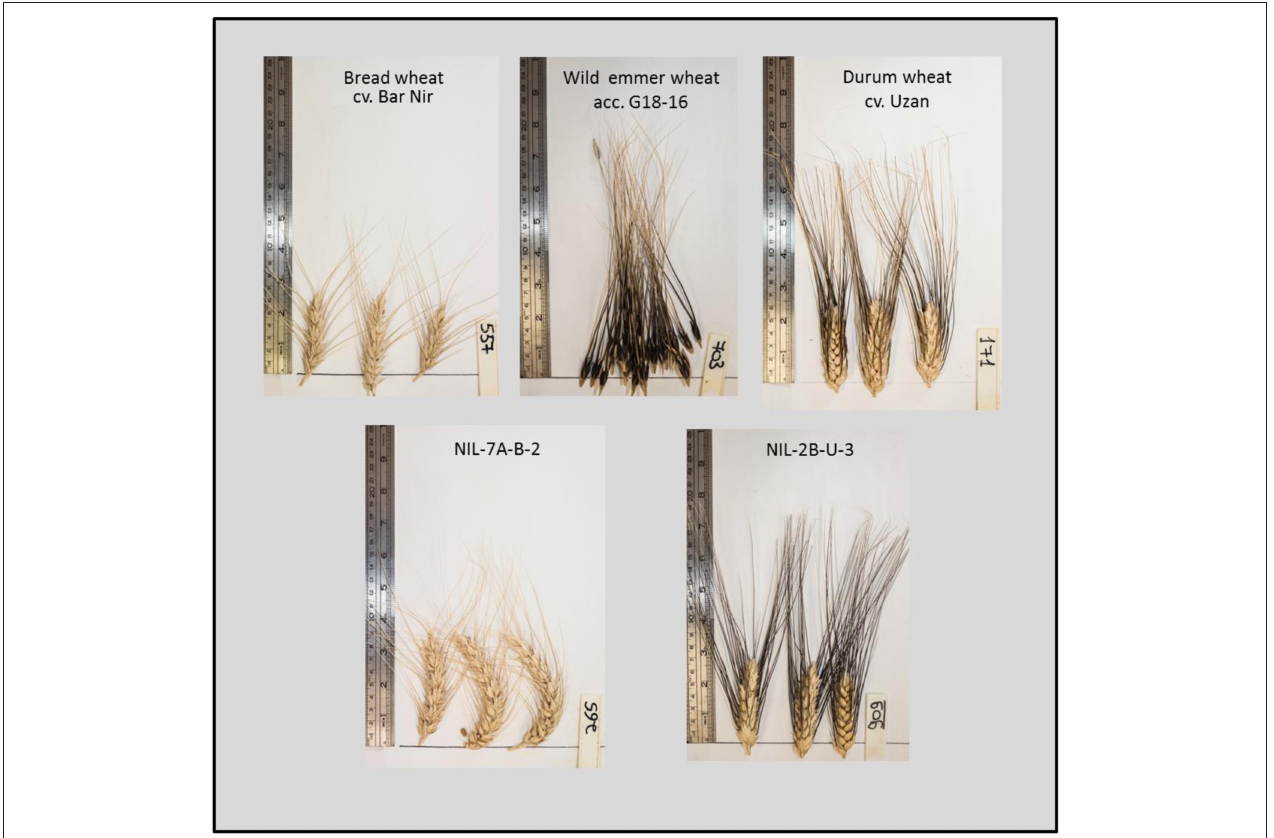
FIGURE 3 | Three first spikes of the wild emmer wheat donor acc. G18-16 (articulated) the recurrent parents bread wheat Bar Nir and durum wheat Uzan and their derivative NILs, grown under water-limited treatment, 2013-14.